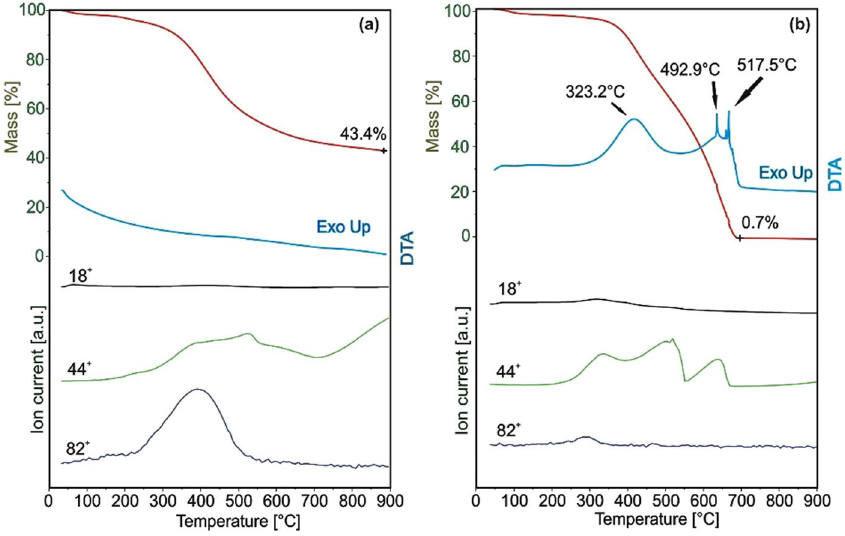
Figure 1. TG/DTA-MS measurements of the carbon nanospheres. ( a ) in helium, ( b ) in air atmosphere. The molecule ions were associated with water (18 + ), carbon dioxide (44 + ) and cyclohexene (82 + ).